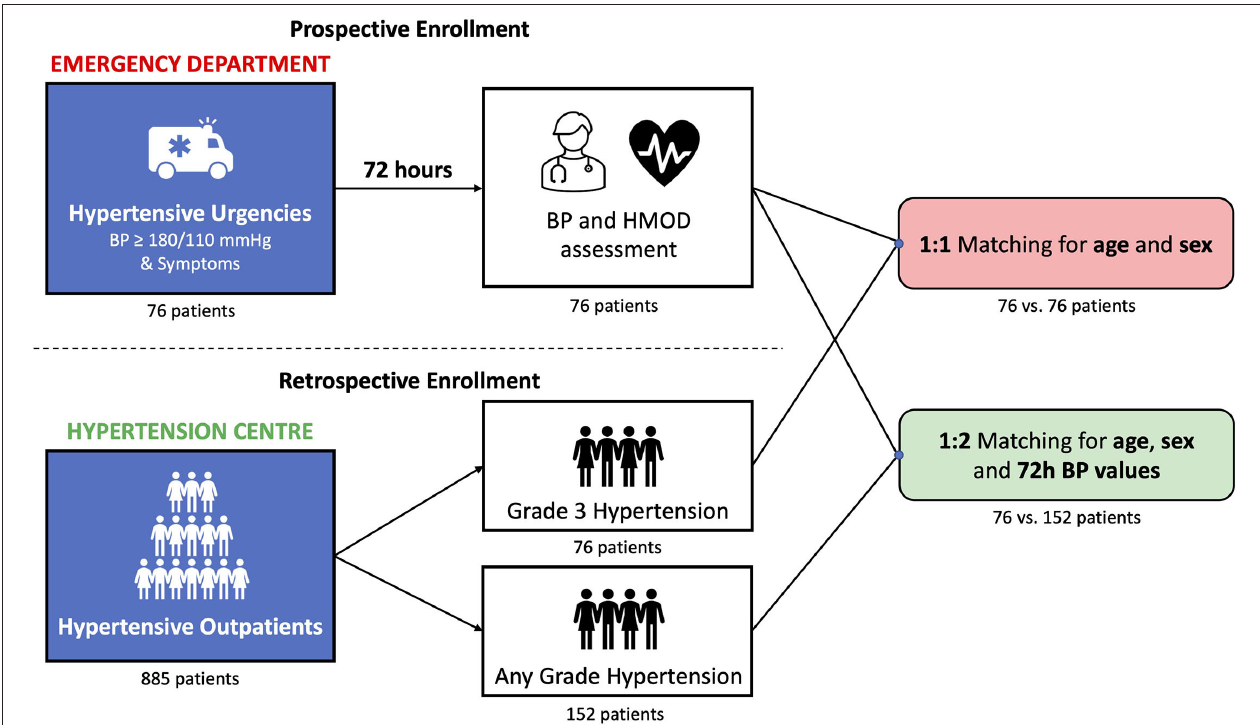
FIGURE 1 | Study design. Prospective and retrospective enrollment and subsequent matching process (details in the main text). BP, blood pressure; HMOD, hypertension-mediated organ damage.